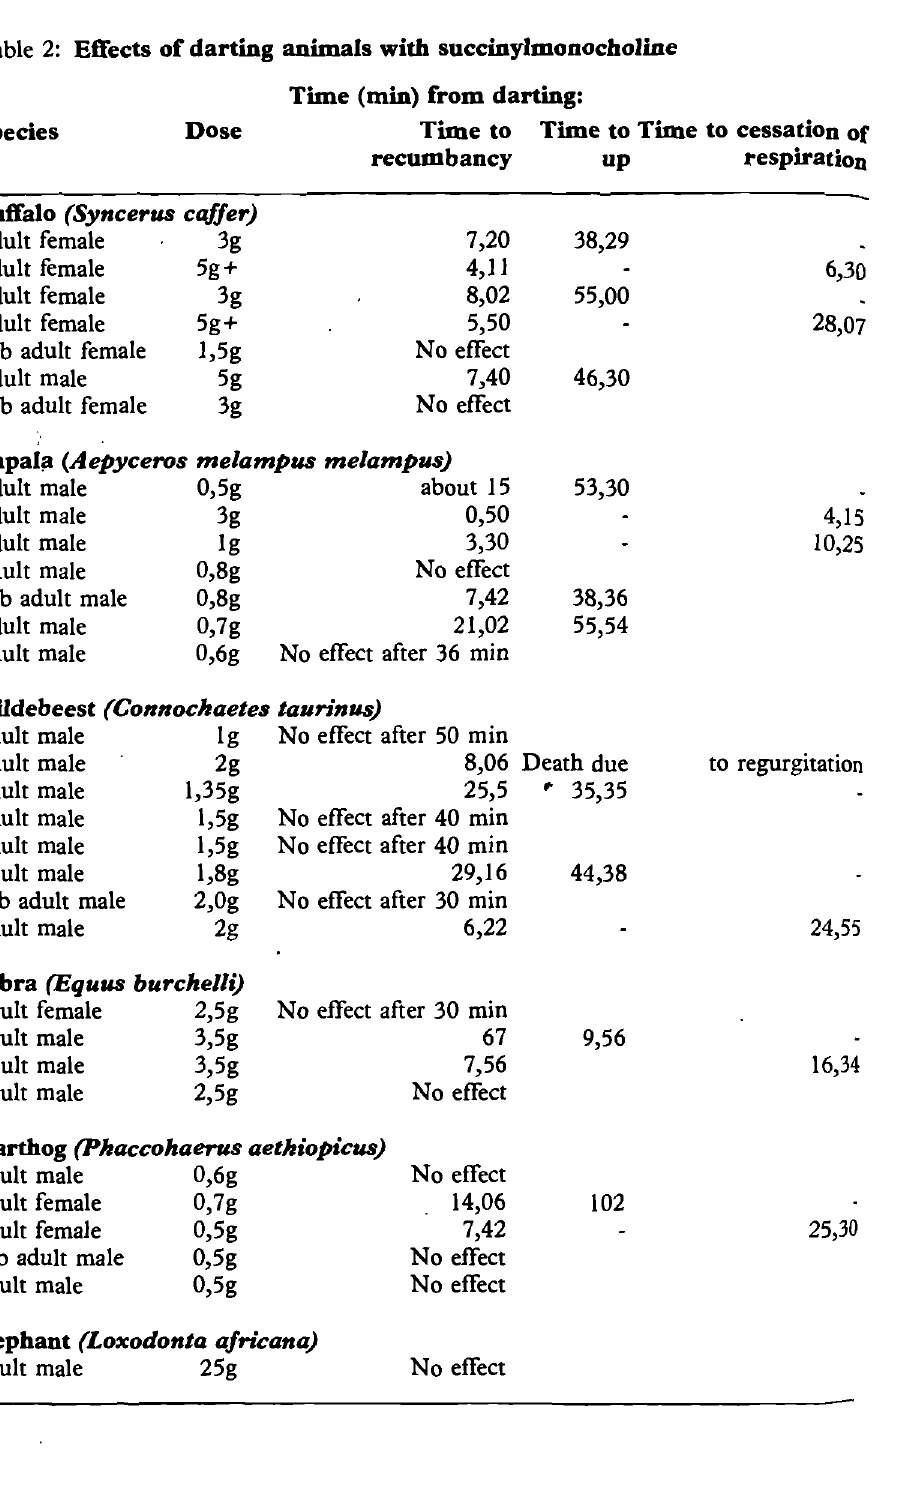
Table 2: Effects of darting animals with succinyJmonochoJine Time (min) from darting: Species